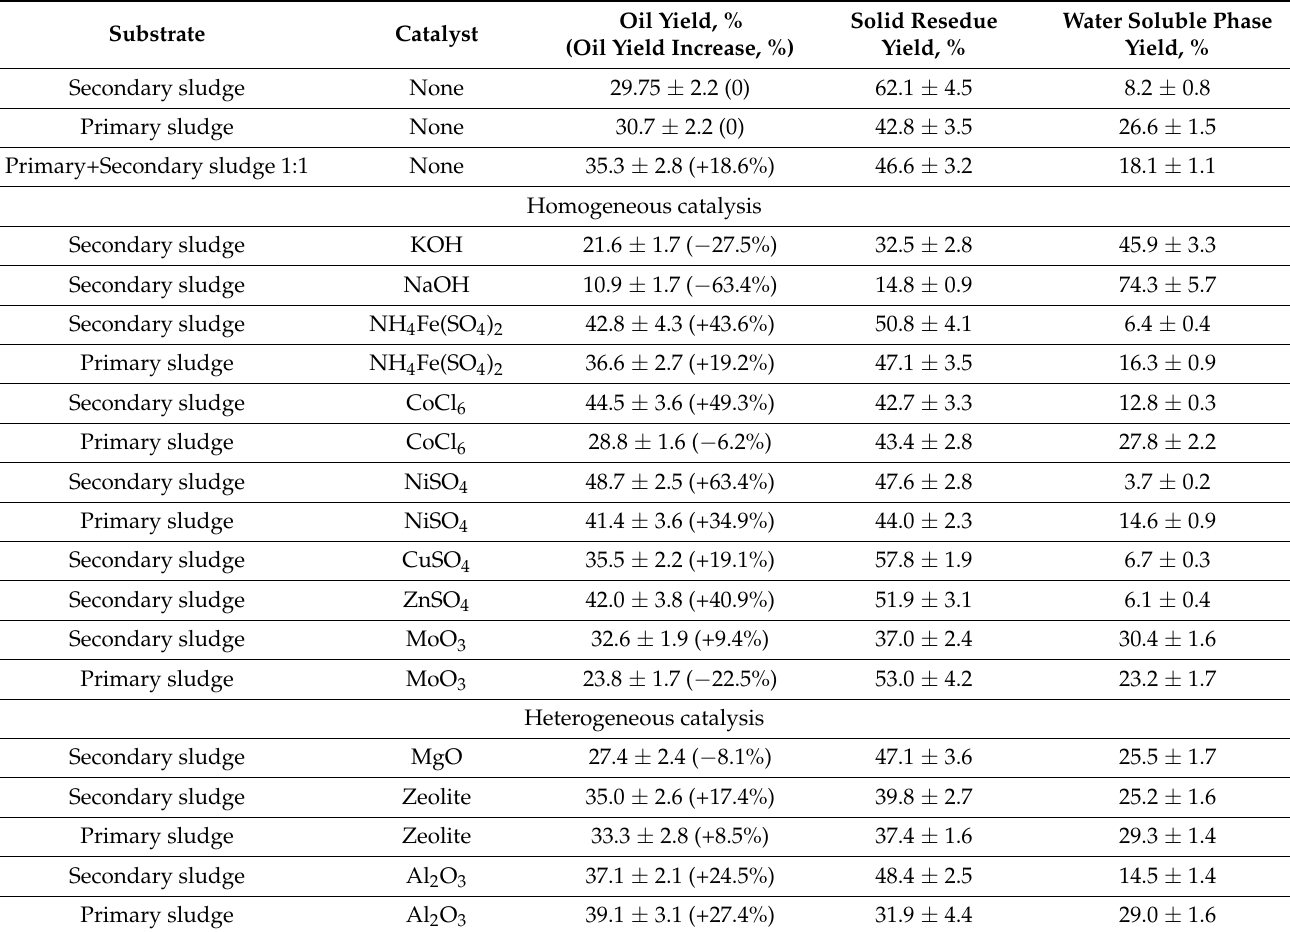
Table 4. Results of HTL